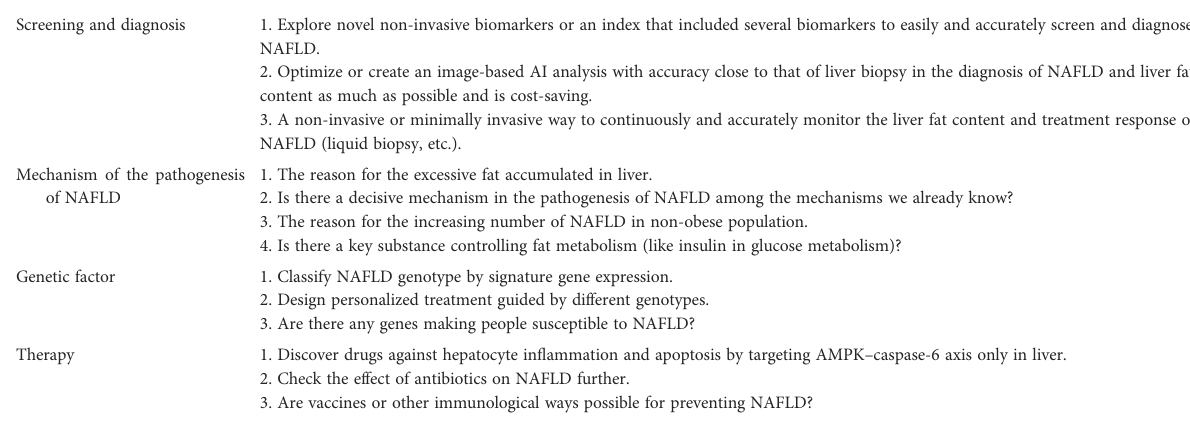
TABLE 2 Potential future